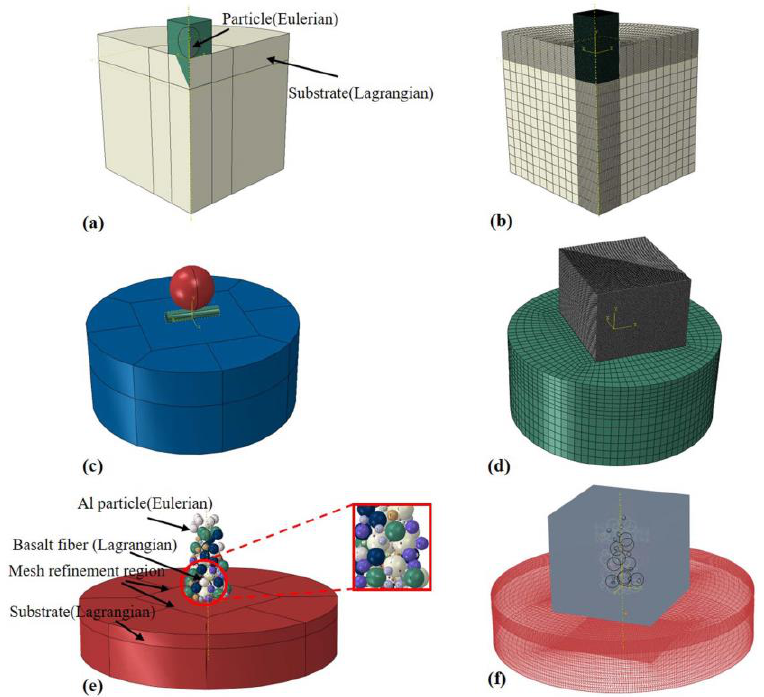
Figure 1. ( a , b ) Al single-particle CEL model and its meshing; ( c , d ) single-particle basalt fiber and single-particle Al impact CEL model and meshing; ( e , f ) random impact model of Al – basalt fiber mixed with multiple particles and meshing. mixed with multiple particles and